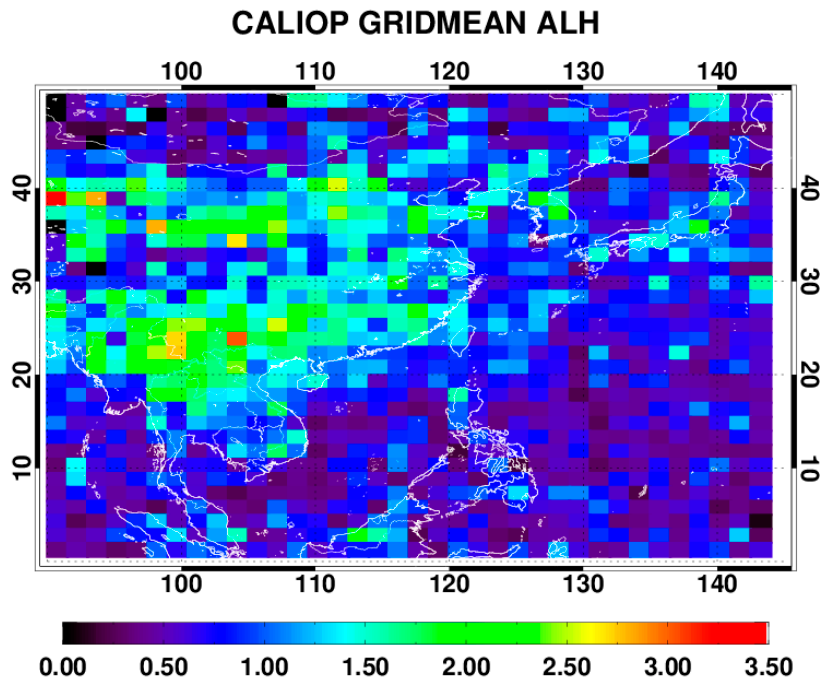
Figure 2. Annual average value of the aerosol layer height (ALH) (km) for 2007 from attenuated backscatter profiles at 1064 nm (1.5 ◦ × 1.5 ◦ resolution). By definition, the ALH is equal to CALIOP-measured attenuated backscatter profiles at 1064 nm (1.5° × 1.5° resolution). By definition, the ALH is equal to the attenuated-backscatter-weighted height. the attenuated-backscatter-weighted